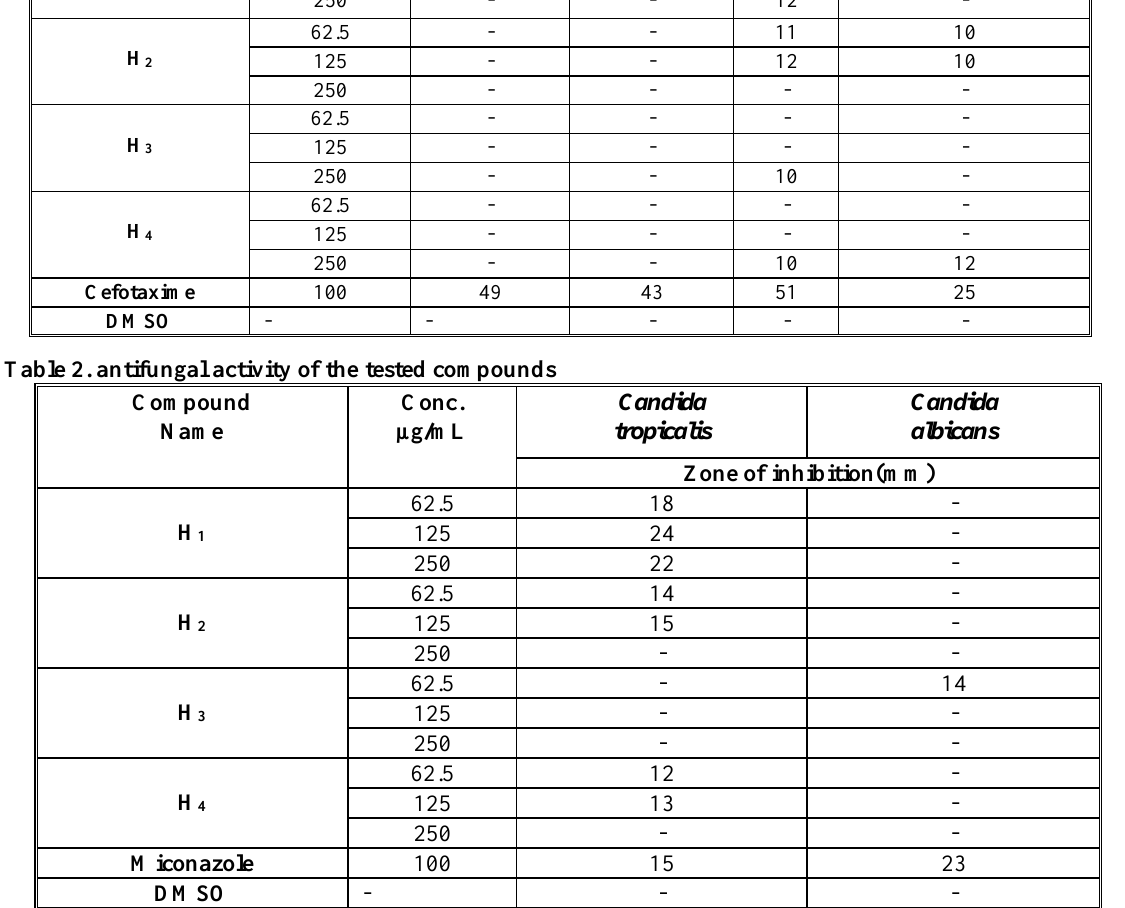
(-) = No activity- slightly active (zone of inhibition between 5-10 mm), moderately active (zone of inhibition between 10-20 mm), highly active (zone of inhibition more Than 20 mm).